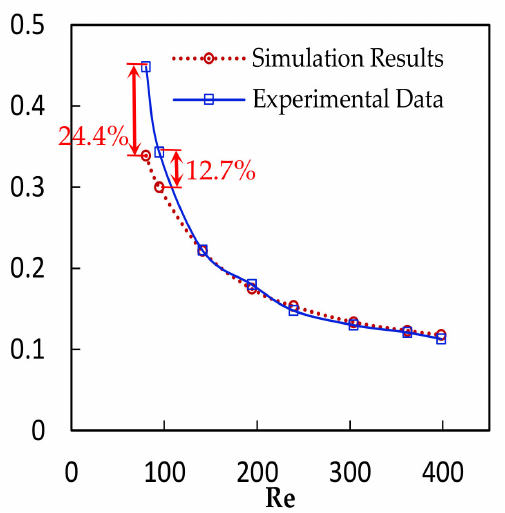
Figure 3. Validation results compared with rectangular MHSs by Kawano et al. [67].